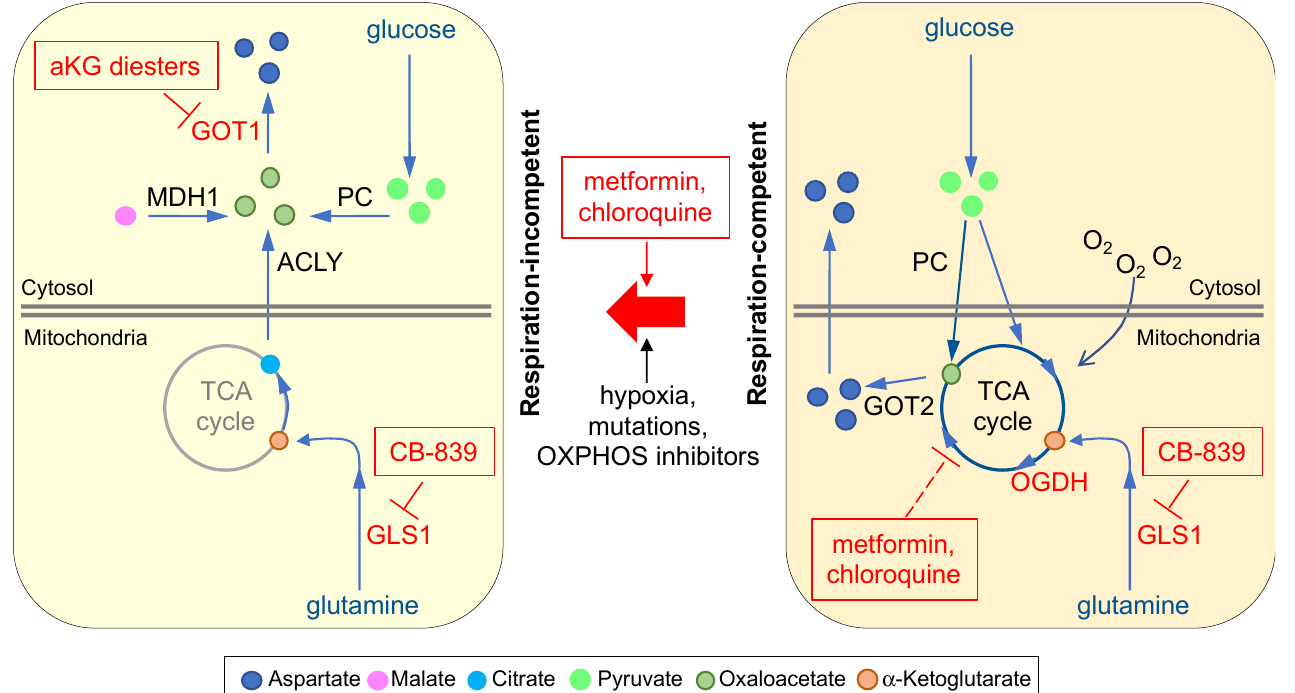
Figure 3. Therapeutic opportunities for abrogating aspartate availability. Protein targets (in red letters, unboxed) and chemical agents (in red letters, boxed) that have already been demonstrated to deplete aspartate in cancer cells or mouse models are shown. Metformin and chloroquine suppress the TCA cycle indirectly. aKG, alpha-ketoglutarate; ACLY, ATP- citrate lyase; GOT1 or 2, glutamic-oxaloacetic transaminase 1 or 2; GLS1, glutaminase 1; MDH1, malate dehydrogenase 1; OGDH, oxoglutarate dehydrogenase; PC, pyruvate carboxylase.